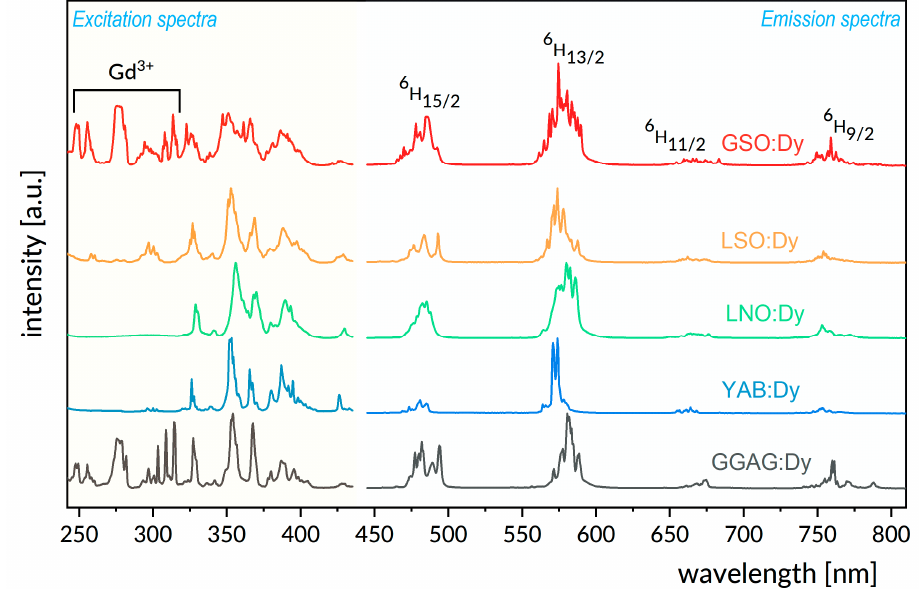
Figure 2. Survey spectra of visible luminescence ( right ) and survey excitation spectra of luminescence monitored at 575 nm ( left ) recorded at room temperature for the systems studied.